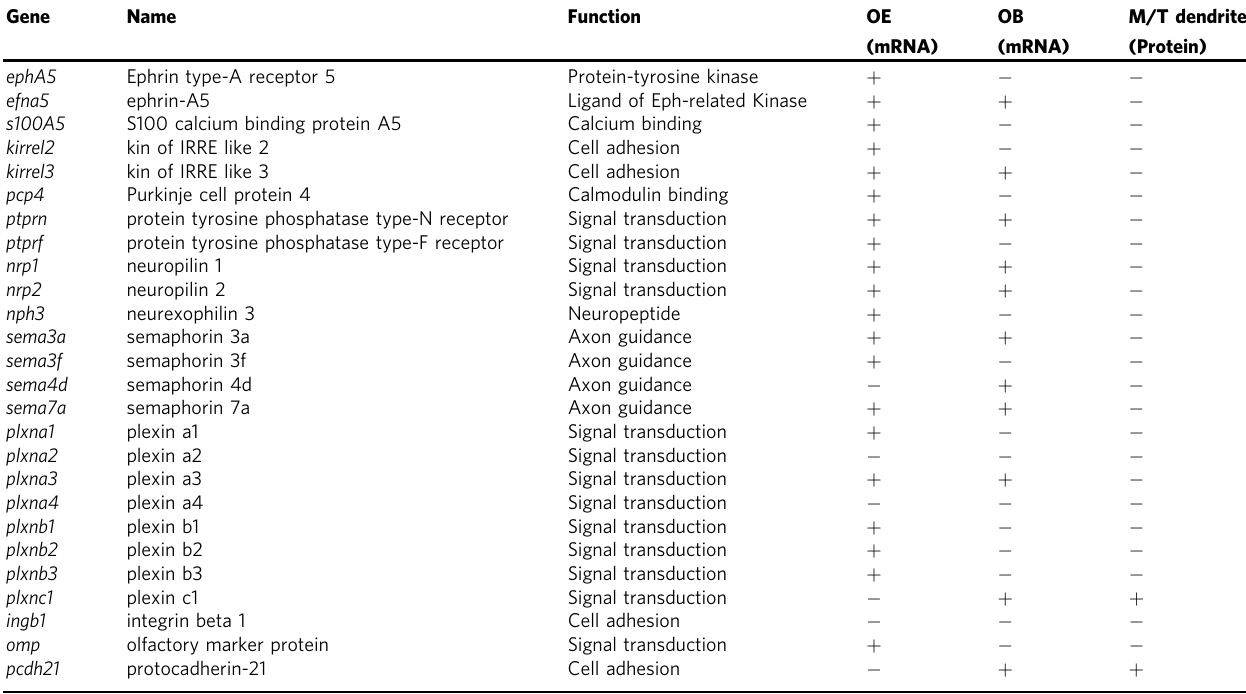
Table 1 Expression of axon guidance, signaling, and adhesion molecules in the OE and OB